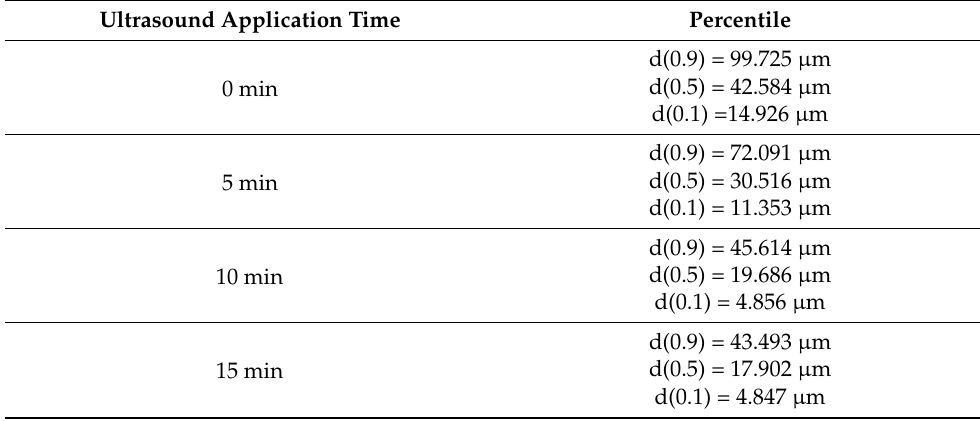
Table 2. Percentiles and particle sizes of the lime diluted in water for different ultrasound application